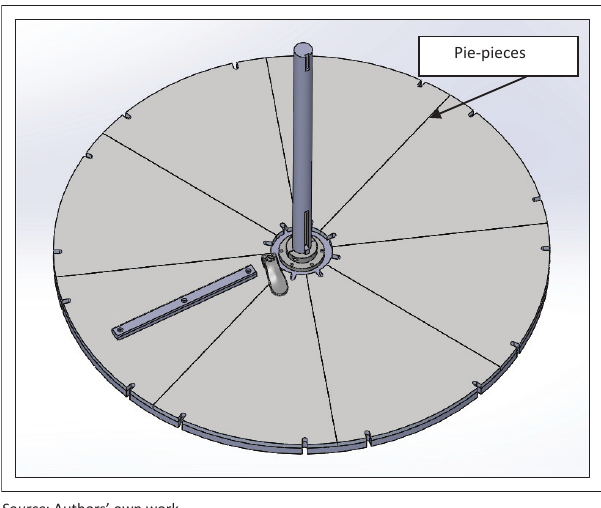
FIGURE 10: Turntable assembly with pie-pieces (only one slat mounted to